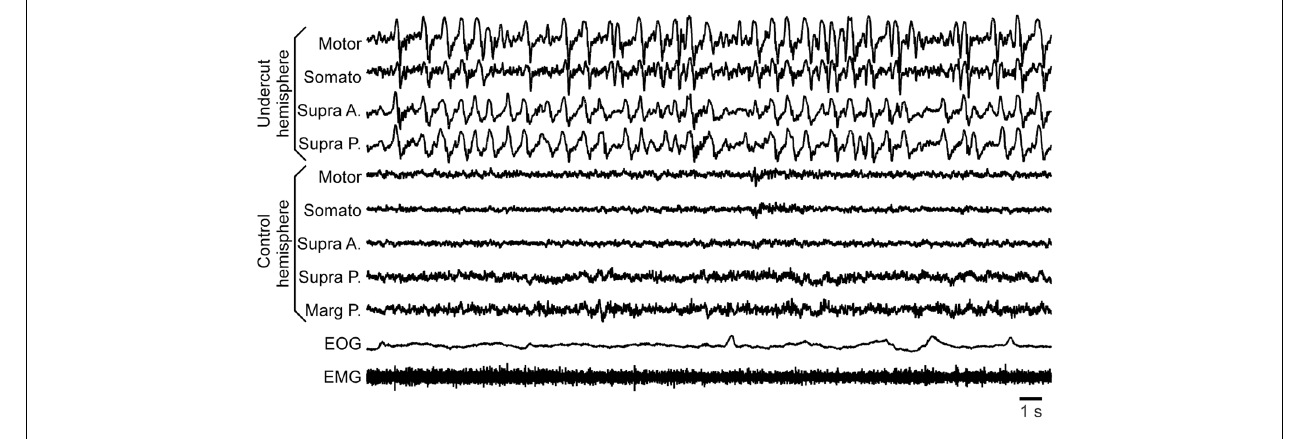
FIGURE 5 | Increased slow-wave activity in a partially deafferented hemisphere. All abbreviations are as in Figure 4